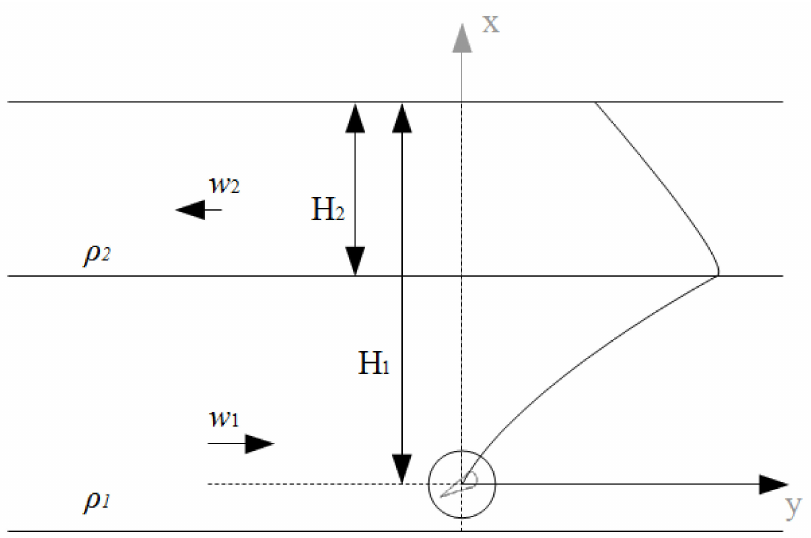
Figure 2. Trajectory of